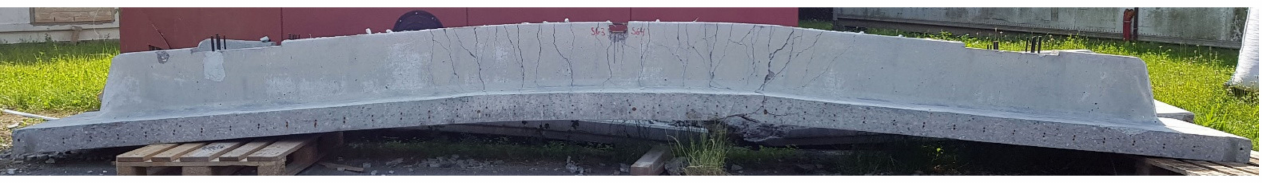
Figure 11. Example of deflected beam after